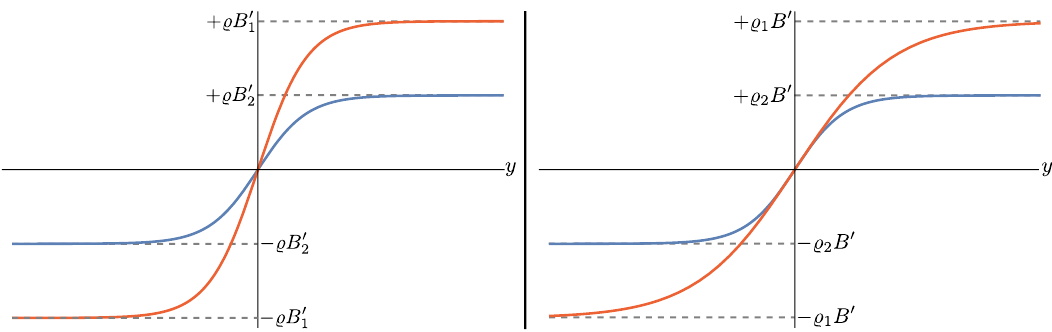
Figure 1 . Magnetic steps (2.24) as a function of y , % , and B 0 . In the left panel, % is the same for both curves but B 0 = 2 × B 0 . On the right panel, B 0 is the same for both curves while % 1 = 2 × % 2 1 2